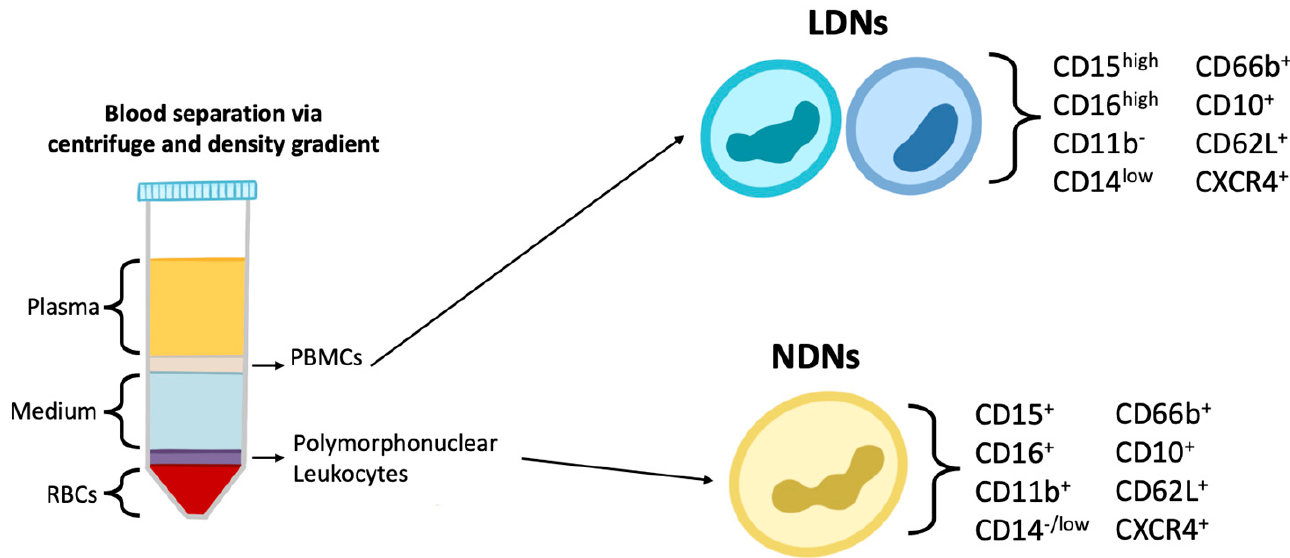
Figure 1. Morphologically distinct subsets of neutrophils are observed in circulation. Isolation of neutrophils from the blood by density gradient centrifugation will give two band layers of leukocytes. The lower band would have the polymorphonuclear cells and is where neutrophils are typically purified from. However, there are neutrophils found in the higher band that have lower density. Blood from healthy individuals was examined for these populations of neutrophils, commonly denoted as low density neutrophils (LDNs) and normal density neutrophils (NDNs). Differences in phenotypic surface markers were observed, as well as differences in their ability to produce reactive oxygen species and phagocytic capacities. Therefore, from blood-derived mononuclear cells, two different subsets can be detected and isolated based on density. Furthermore, these two subsets are functionally different and can be distinguished by flow cytometric assessment of surface markers [92].